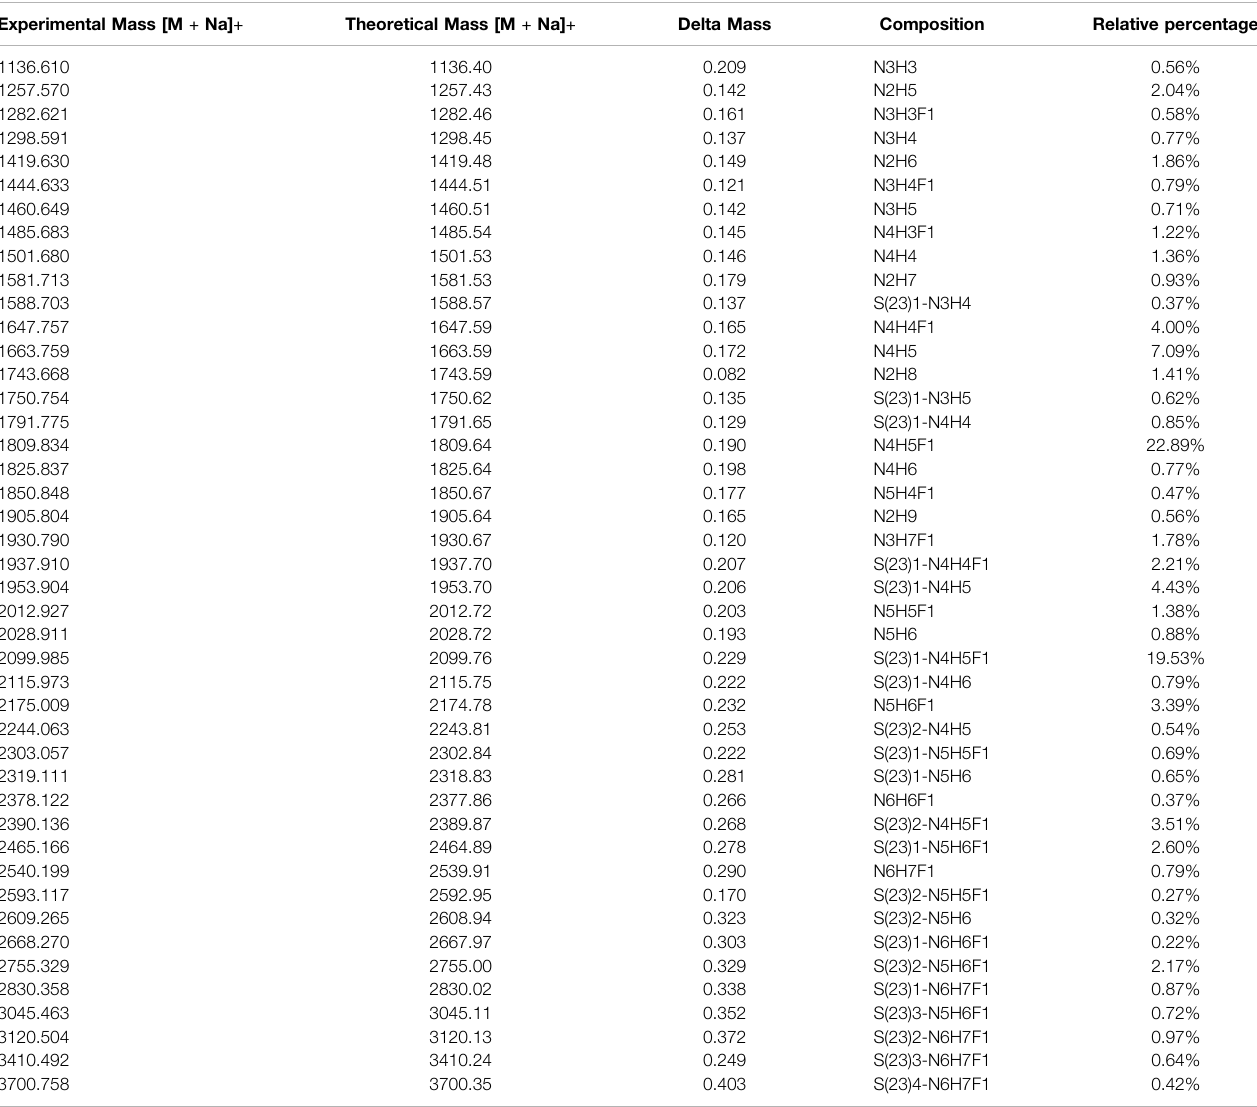
TABLE 1 | Released N-glycans identi fi ed from CHO-Spike protein. Experimental Mass [M + Na]